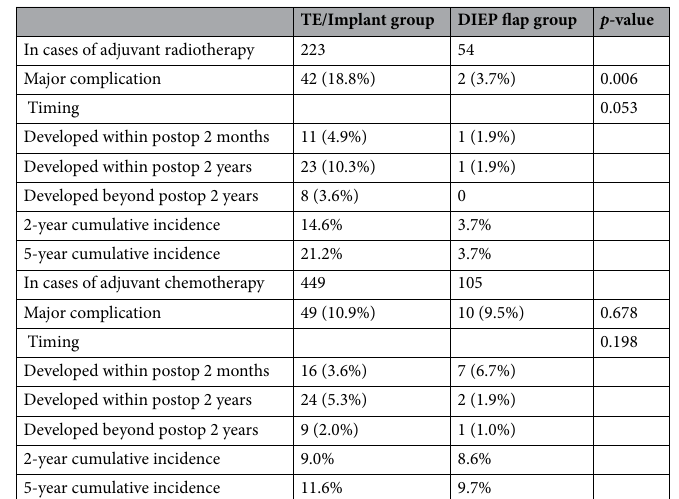
Table 4. Comparison of cumulative incidence of major complications between two groups according to adjuvant oncologic treatments.